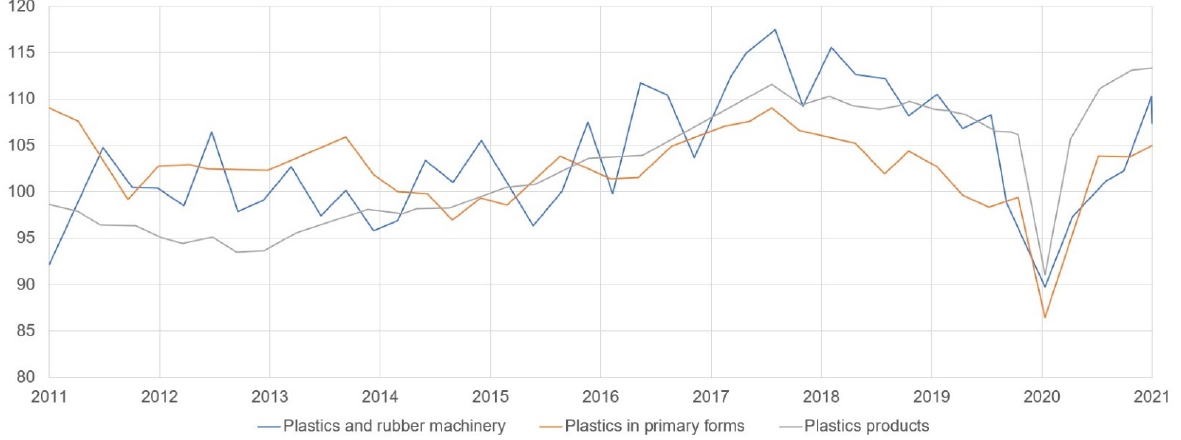
Figure 1. Plastic industry production in EU27 (index 2015 = 100, seasonally adjusted quarterly data)